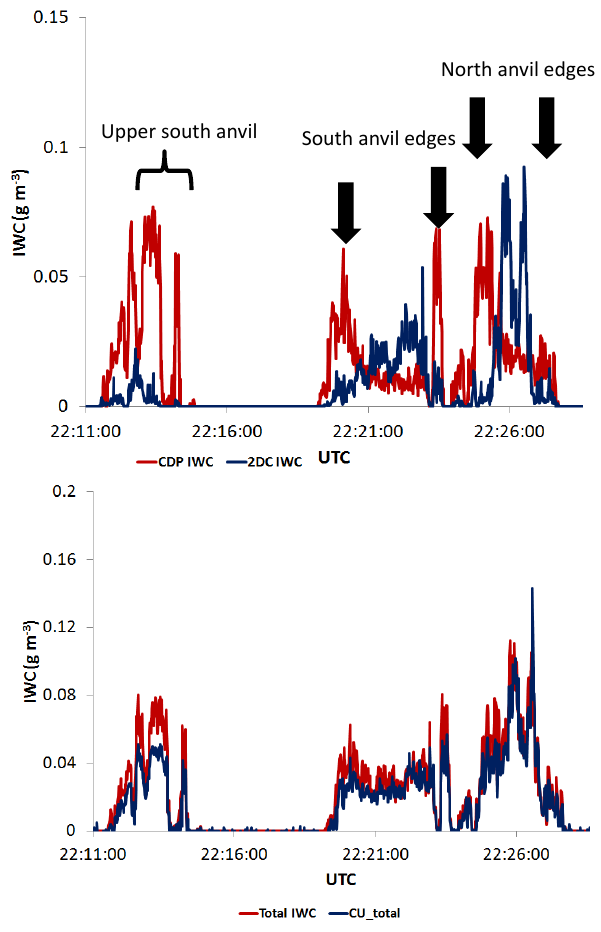
Fig. 11. Ice water content data from the anvil sampling depicted in Figs. 3 and 4. Ice water content from the CDP (red) and 2DC (blue) is depicted in the top plots. Combined CDP + 2DC ice water content (red) is compared with the ice water content measured by the CLH-2 (blue) in bottom